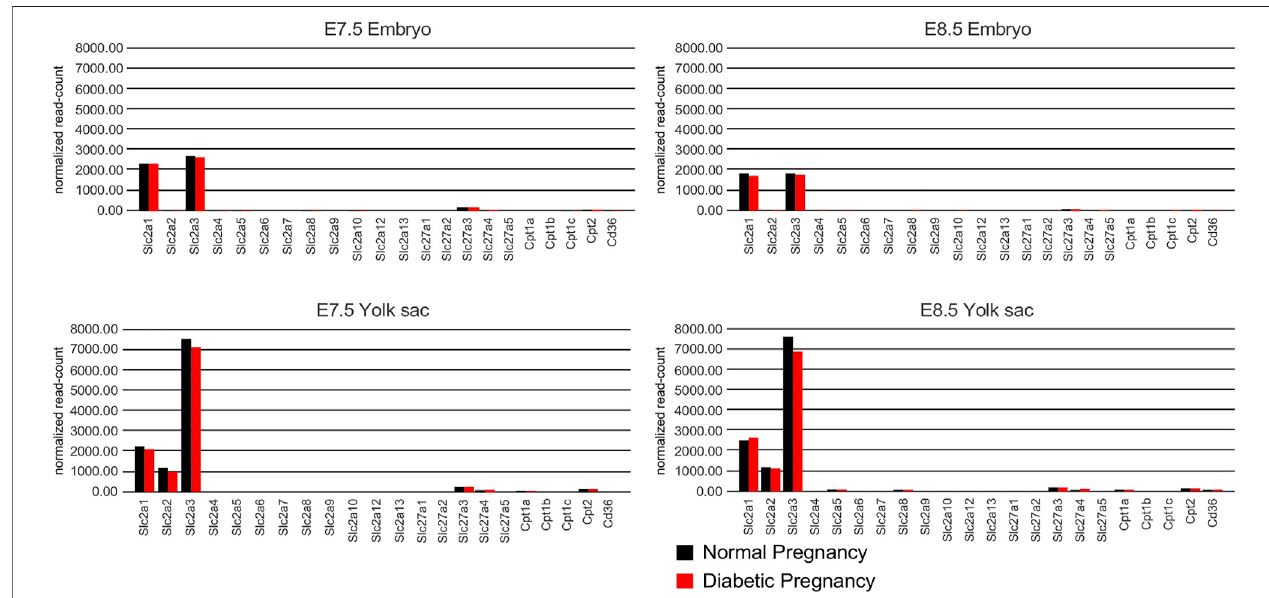
FIGURE9 | RNA sequencing results from embryos and corresponding visceral yolk sacs isolated from normal and diabeticpregnancies ofthe NOD strain at E8.5. The Y -axis depicts the number of unique molecular identi fi er (UMI) sequence reads for each gene. Bars represent the average of n = 17 pairs of embryo and correspondingyolksac foreach groupatthe5and6somite stage, and n =16samplepairsforeach groupat the7 – 9somite stage.Barsareabsentforgenesthatwere undetectable or yielded a read number smaller than 10. No statistically signi fi cant differences were found between the averages for samples from normal and diabetic pregnancies, except for Slc2a4 detection in 5/6 somite stage embryos (see Supplementary Table S1 for numerical data).